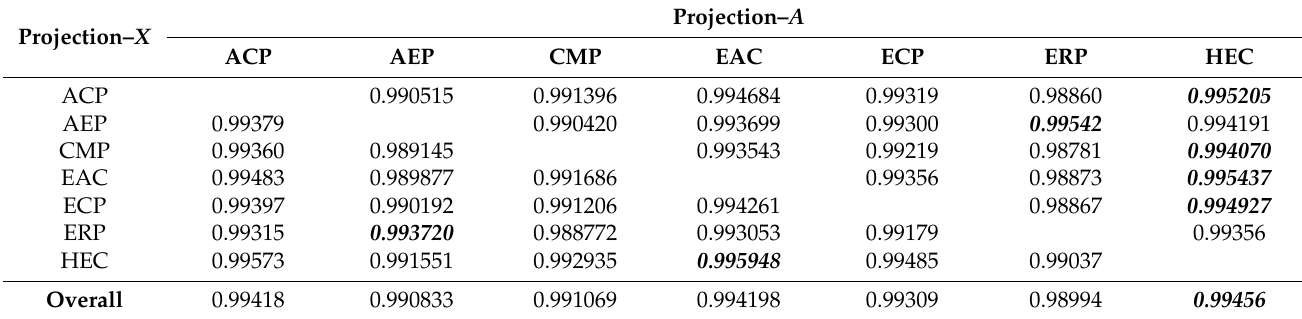
Table 2. Comparison using SSIM (average values at 2K, 4K, and 6K).